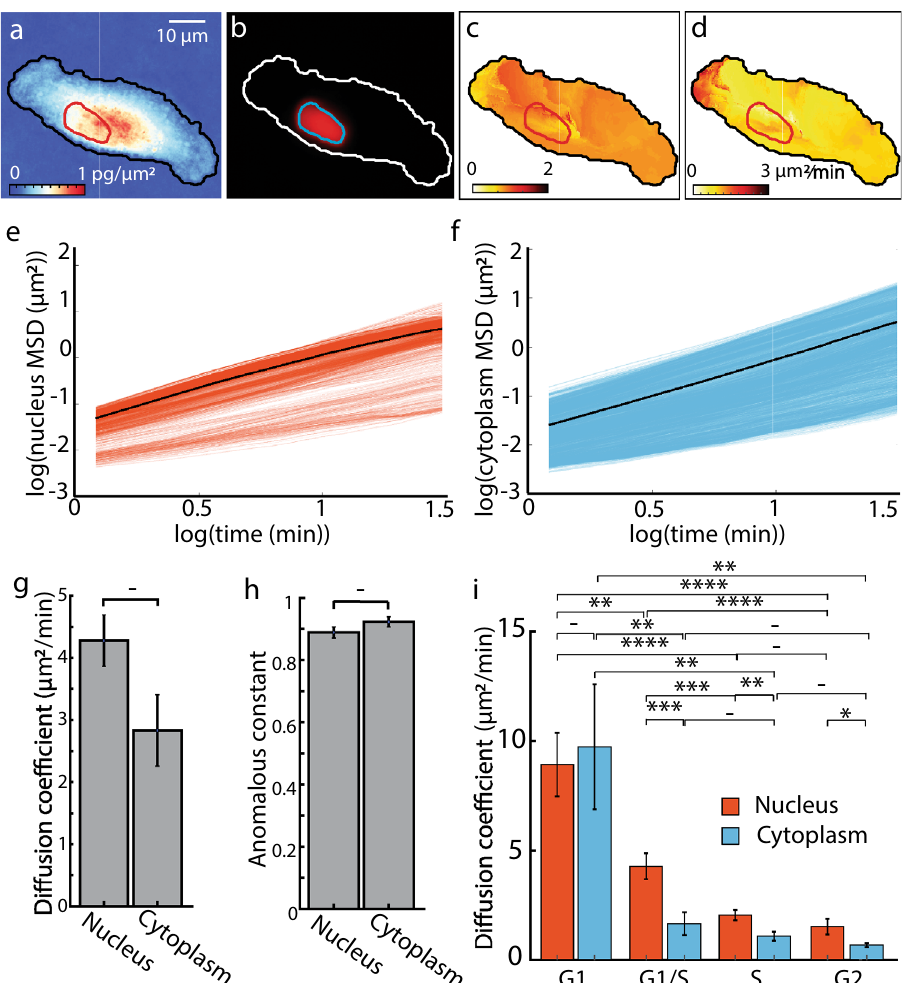
Figure 5. Mean squared displacement (MSD) analysis shows reduced diffusion coefficient in RPE cells with cell cycle progression. ( a ) QPI image of individual RPE cell with red nuclear and black cytoplasmic boundary shown. ( b ) Anomalous constant distribution within the RPE cell from ( a ). ( c ) Diffusion coefficient distribution within the RPE cell from ( a ). ( e ) Logarithm of MSD vs time lag of nuclear volumes of the RPE cell in ( a ). The black line shows the mean of all nuclear volumes. ( f ) Logarithm of MSD vs time lag of intracellular cytoplasm volumes of RPE cells in ( a ). Black line shows the mean of all cytoplasmic volumes. ( g ) Separation of diffusion coefficient in nucleus and cytoplasm of the RPE live cells shows moderate, but not significant reduction in diffusion coefficient in the cytoplasm relative to the nucleus. ( h ) The anomalous constants from the MSD analysis on the same cells shows moderately sub-diffusive transport in both the nucleus and cytoplasm. ( i ) Nuclear and cytoplasmic diffusion coefficients in RPE cells over the cell cycle from n = 119 cells. Error bars show standard error of the mean. – p > 0.05 (not significant), ** p < 0.01, *** p < 1 × 10 –3 , **** p < 1 × 10 –4